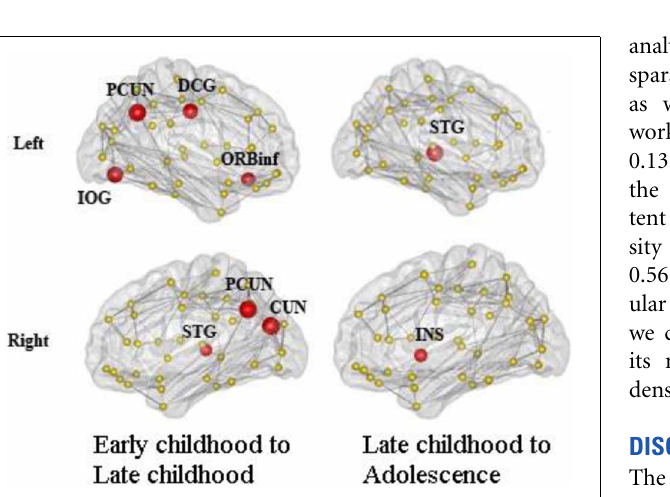
FIGURE 6 | Regions with significantly increased nodal efficiency from early childhood to late childhood and late childhood to adolescence. Seven regions had increased nodal efficiency ( P < 0 . 05, FDR corrected) from early childhood to late childhood and two regions from late childhood to adolescence. Most regional changes from early to late childhood are in the default-mode system, including bilateral PCUN and left DCG. Left STG and right INS have increased efficiency from late childhood to